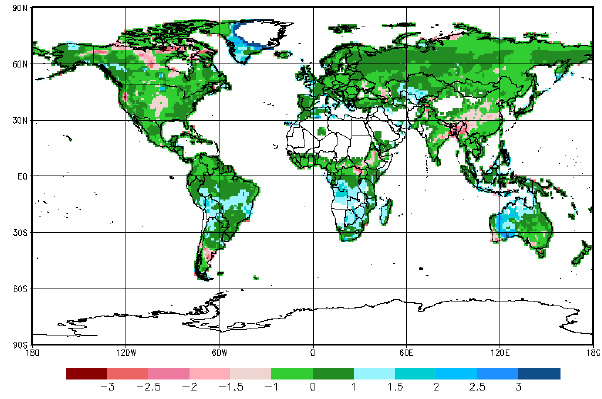
Figure 4. The SPI-DWD for January 2014 with 3-month aggrega- tion interval. The color scale is the same as in Fig. 3.